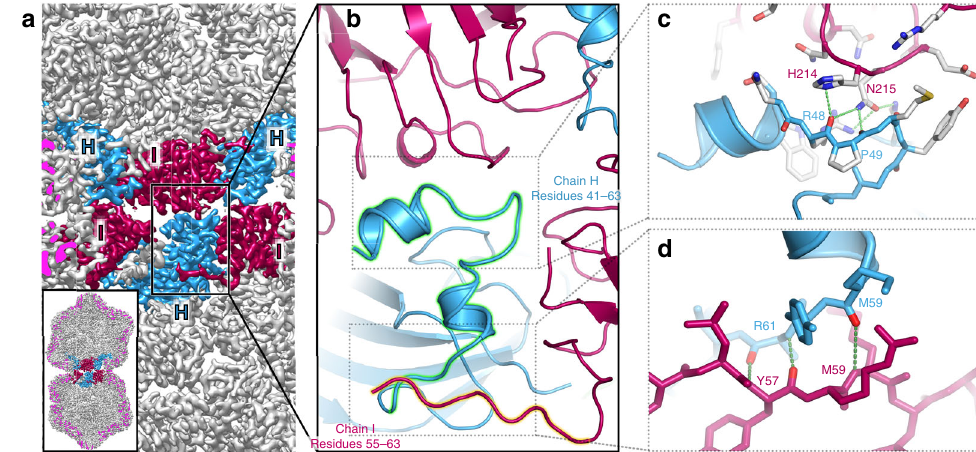
Fig. 2 Building a geminate capsid. a Rear half of the EM density for AYVV at 3.3 Å resolution. The cut surface of the EM density is colored bright magenta for clarity. Three CP subunits from each hemisphere are colored as in Fig. 1. In the top hemisphere, these are H-I-H (blue-maroon-blue) and in the bottom hemisphere these are I-H-I (colored maroon-blue-maroon). b Zoomed-in view of the interactions that form the interface. A helix-loop-helix motif comprising residues 40 – 63, becomes ordered only in subunit H (green halo), whilst an extra segment (residues 55 – 63) in subunit I also becomes ordered (orange halo) but in a different conformation to that seen by the same residues in chain H. c Details of the interactions across the equatorial interface. The loop in the helix-loop-helix motif makes H-bonding and van der Waals interactions with a patch of polar residues (214 – 215) on the opposing subunit. This patch is normally exposed on the surface of the subunits that form the isometric parts of the capsid (see Supplementary Fig. 4). d Details of the interaction between the two different N-terminal conformations. Effectively a beta-strand interaction is formed from backbone H-bonding of residues 59 – 61 in H (blue) and residues 56 – 59 in I, which helps to stabilize the ring of H & I subunits within a